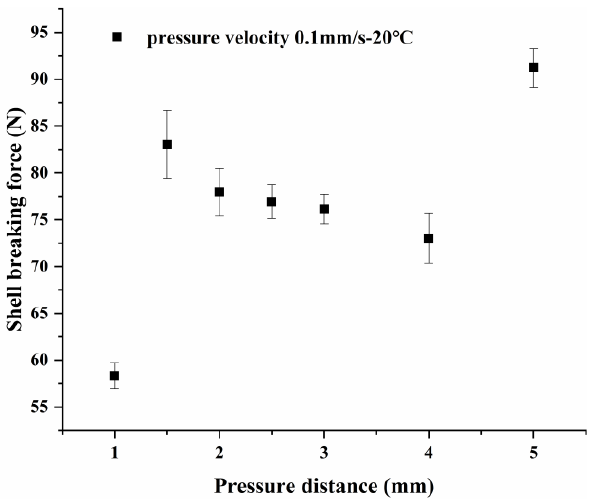
Figure 3. Pressing distance – mechanical properties of shell breaking force.